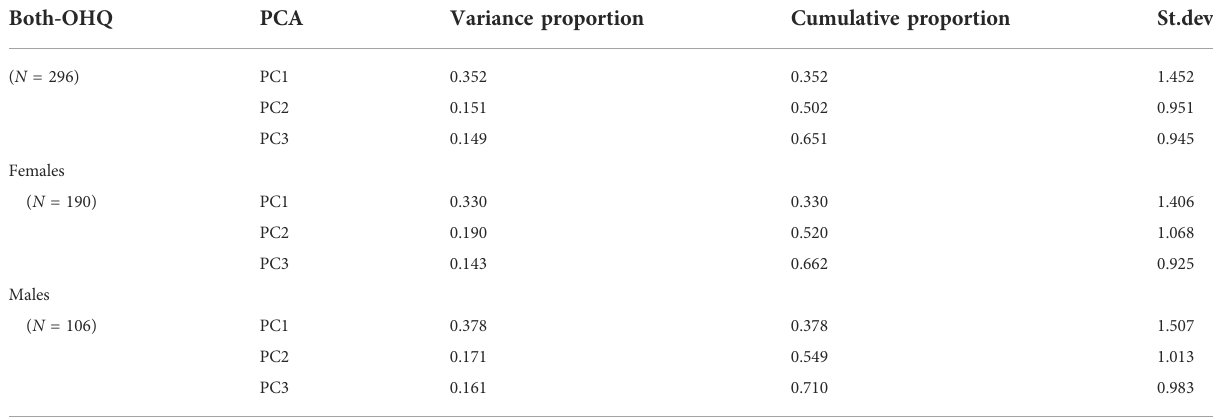
TABLE 2 Principal components analysis of the variation for the reversed OHQ score and phenotypes in ranges of typical variation for schizotypy, autism spectrum cognition, attachment-related anxiety, sleep and emotional eating, as also shown in Table 1. The principal components were calculated from eigenvalues on the correlation matrix, only the three largest principal components are shown for each analysis.